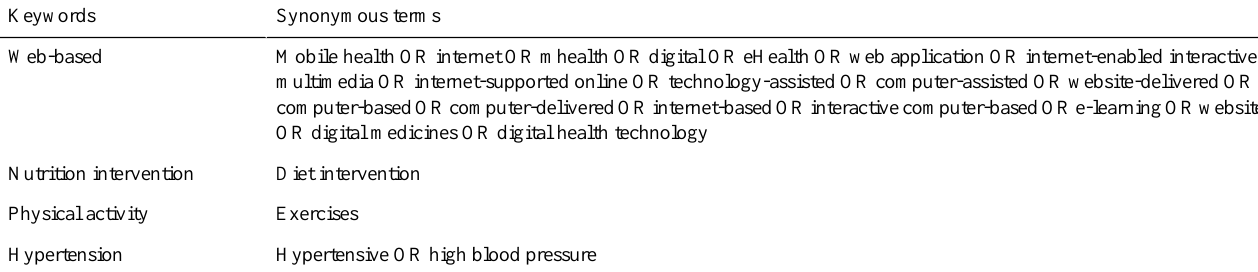
Table 1. The search terms that were used by the